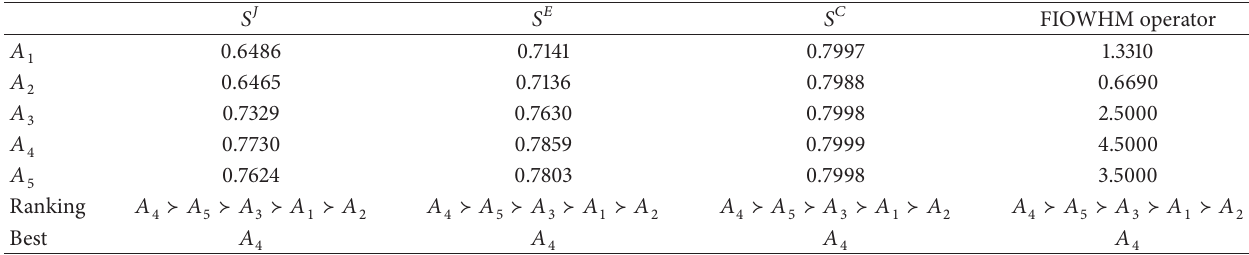
Table 6: Decision results of different methods in the same numerical